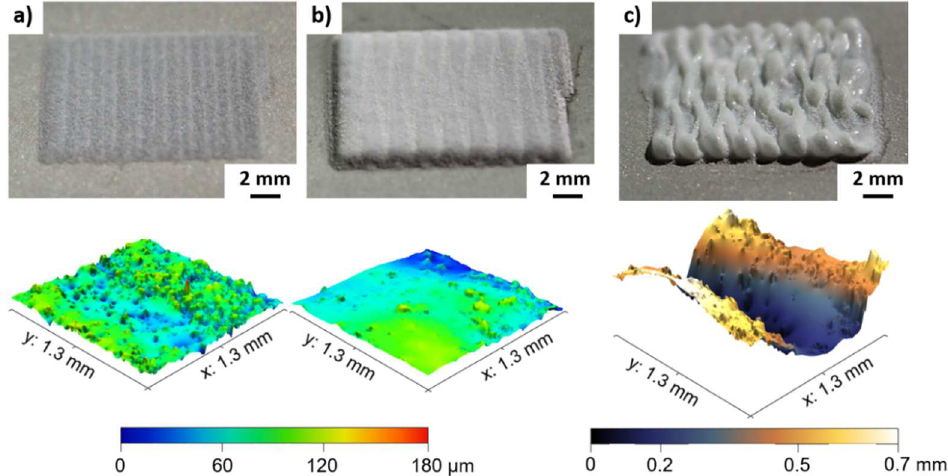
Figure 6. Photographic images (top) and corresponding 3D view of color-coded height maps (bottom) show surface topography of PA12 coatings deposited by a powder mass flow of 0.6 g/min for energy densities of ( a ) 2.1 J/mm 2 , ( b ) 2.9 J/mm 2 and ( c ) 3.6 J/mm 2 .